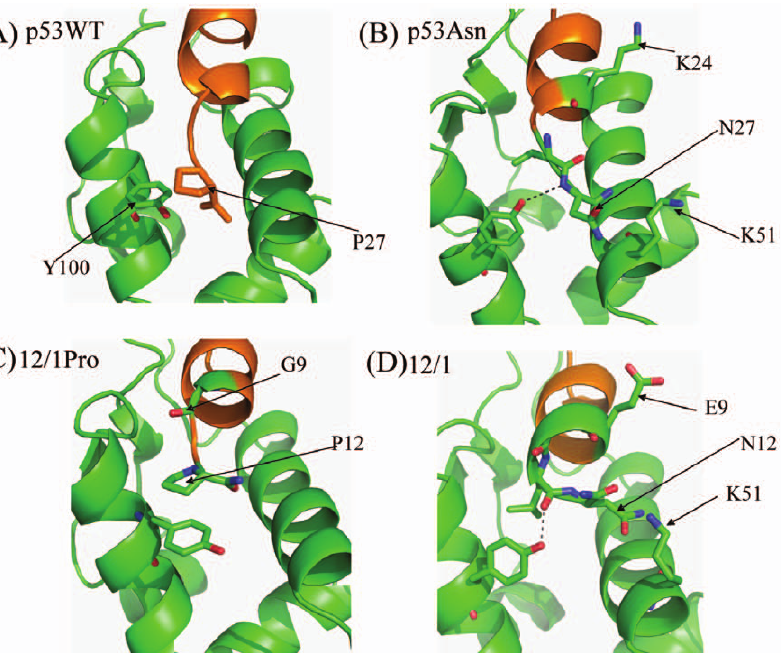
Figure 8. Representative snapshots from the trajectories of the WT p53 and the two C-terminal Pro substituted peptides illustrating the different interactions formed with MDM2. Representative snapshots from the trajectories of (A) WT p53 (B) P27N mutant of p53 (C) N12P derivative of the 12/1 family and (D) the 12/1 peptide complexed with MDM2 showing the different interactions formed by similar substituent amino acids at the C-terminal end of two peptide